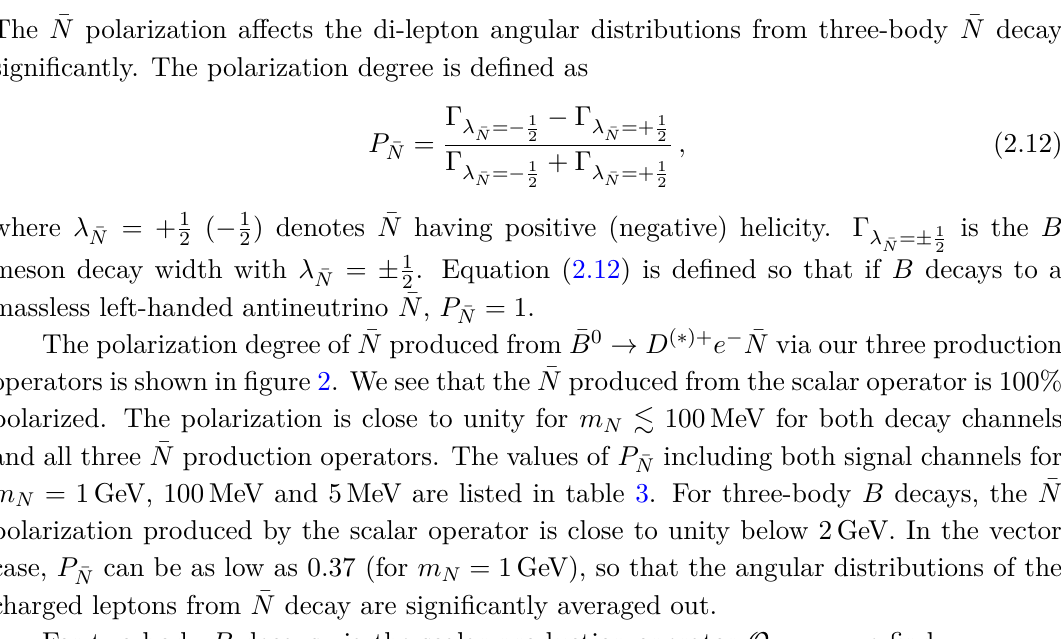
Table 3 . Polarization degree of ¯ N from B meson